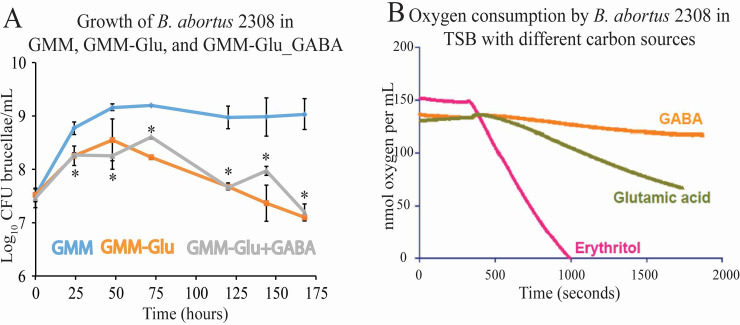
GABA is not utilized as a metabolite by B. abortus 2308 in vitro.A. Growth of B. abortus 2308 in minimal medium (GMM), minimal medium lacking glutamate (GMM-Glu), and minimal medium lacking glutamate with the addition of GABA (0.15%) (GMM-Glu+GABA). The asterisk denotes a statistically significant difference (* P<0.05; Student’s t test) in uptake between B. abortus 2308 grown in GMM compared to B. abortus 2308 grown in either GMM-Glu or GMM-Glu+GABA. B. Oxygen consumption by B. abortus 2308 grown in TSB with the addition of either GABA, glutamate, or erythritol 300 seconds after inoculation measured via oxygraph machine.